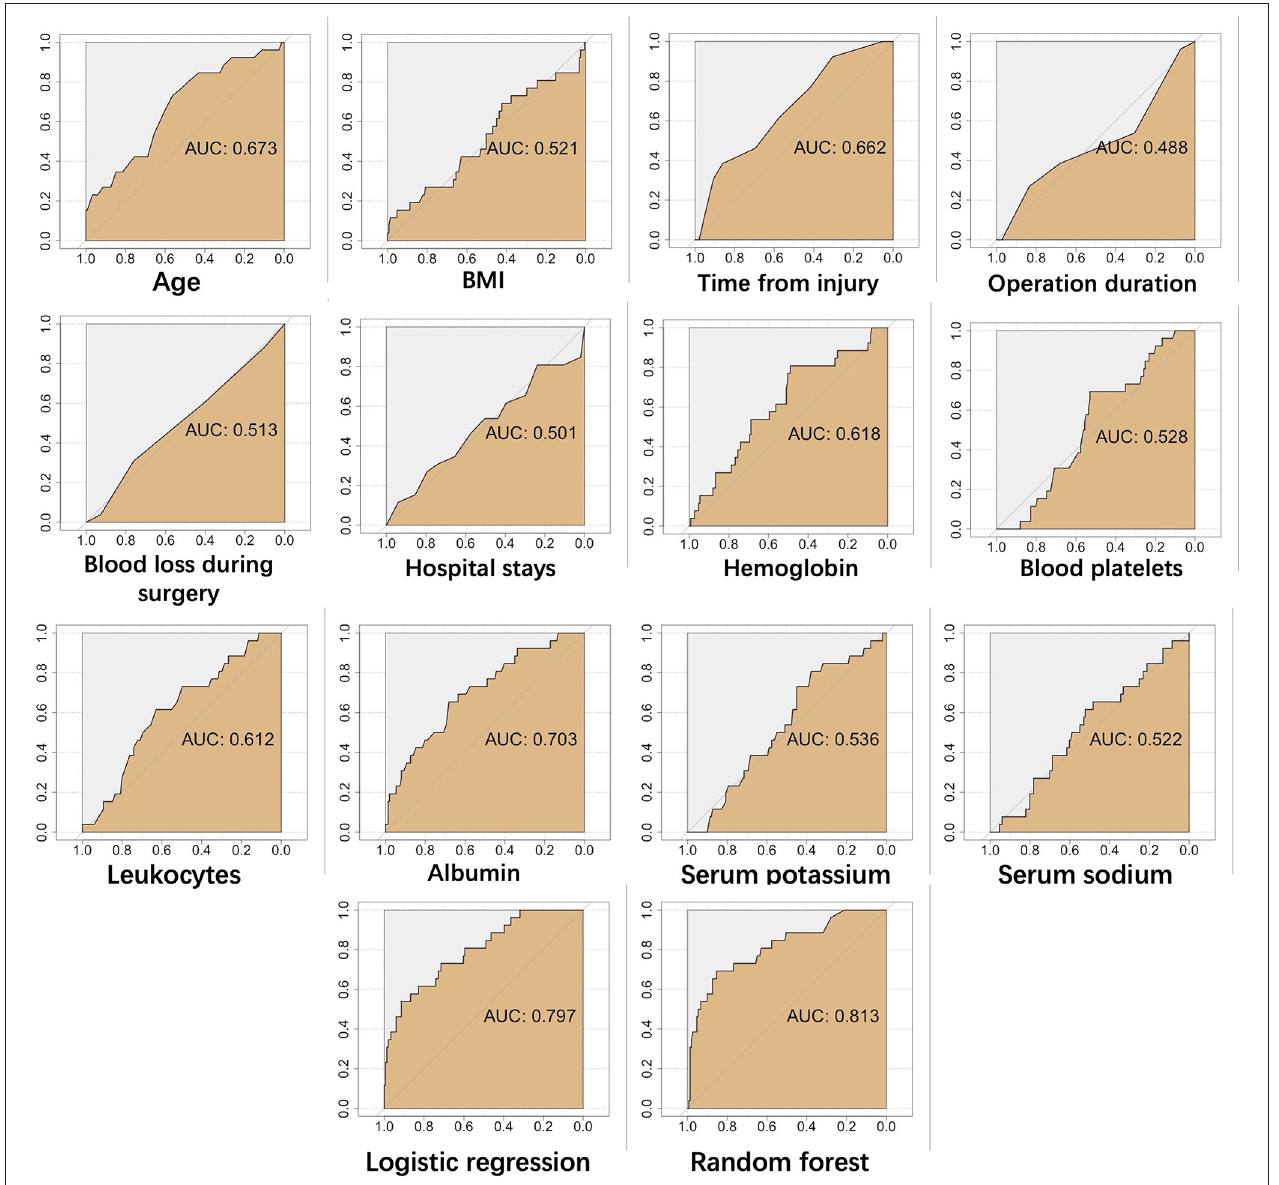
FIGURE 7 | The ROC curves of continuous variables, prediction model constructed by random forest algorithm, and traditional logistic regression in testing